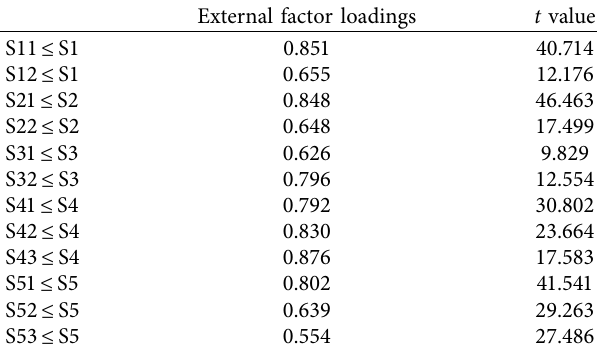
Table 4: Analysis results of external weights and factor loadings of the